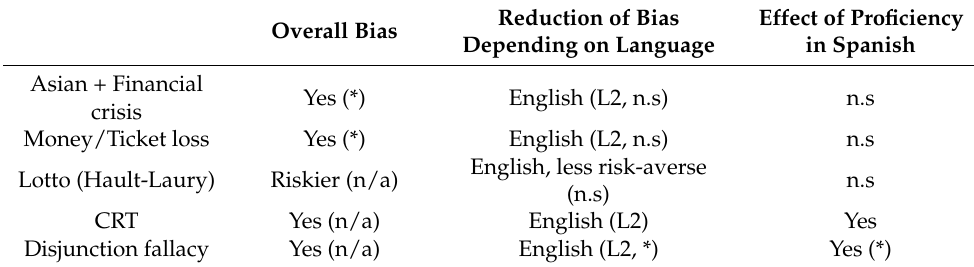
Table 17. Results